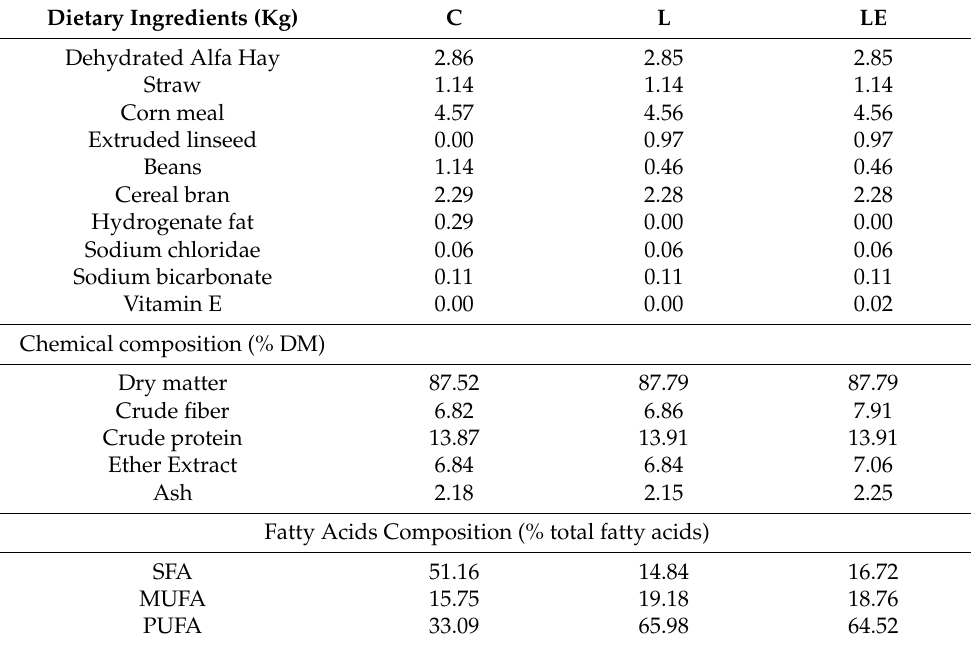
Table 1. Ingredients of the three experimental diets: C (control), L (linseed) and LE (linseed + vitamin E). Dietary Ingredients